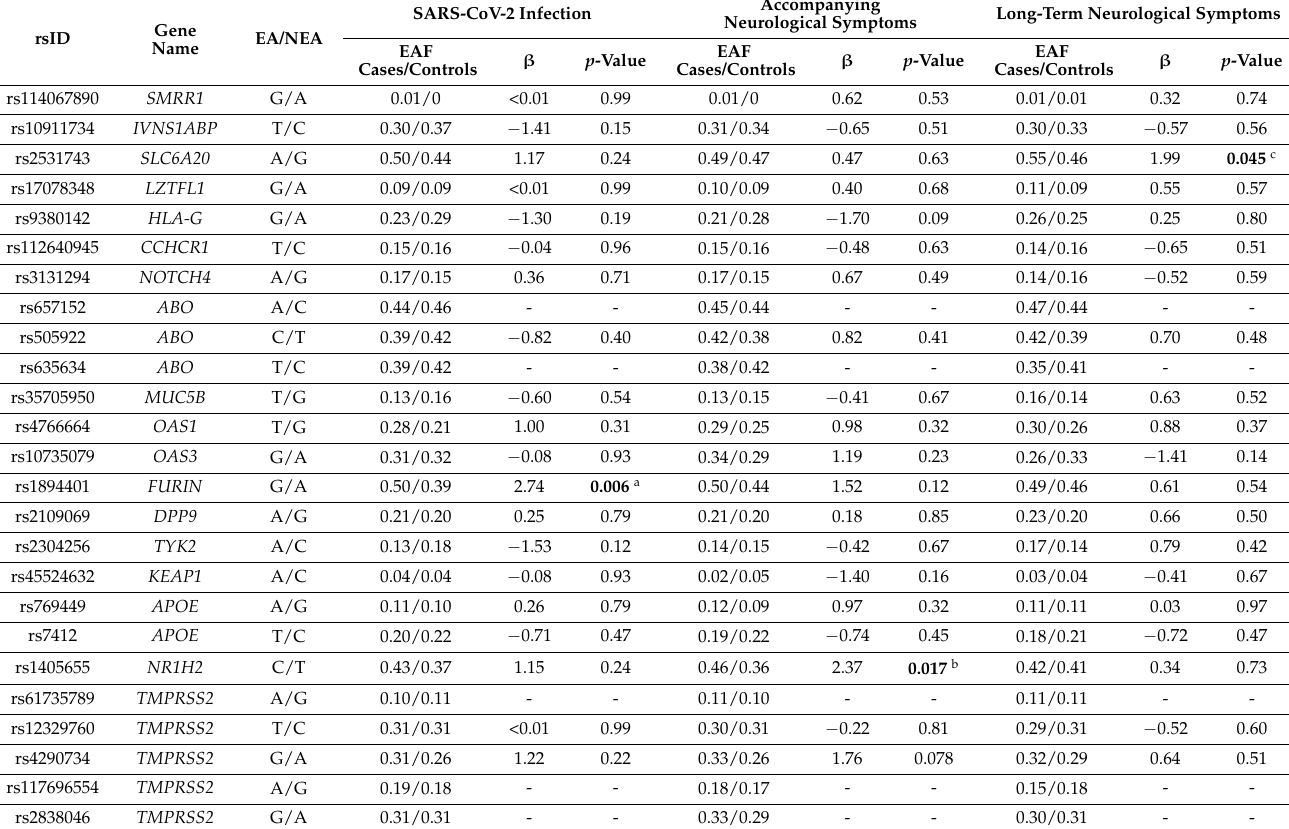
Table 2. Logistic regression analysis (log-additive models) demonstrating the effects of examined SNPs on COVID-19-related